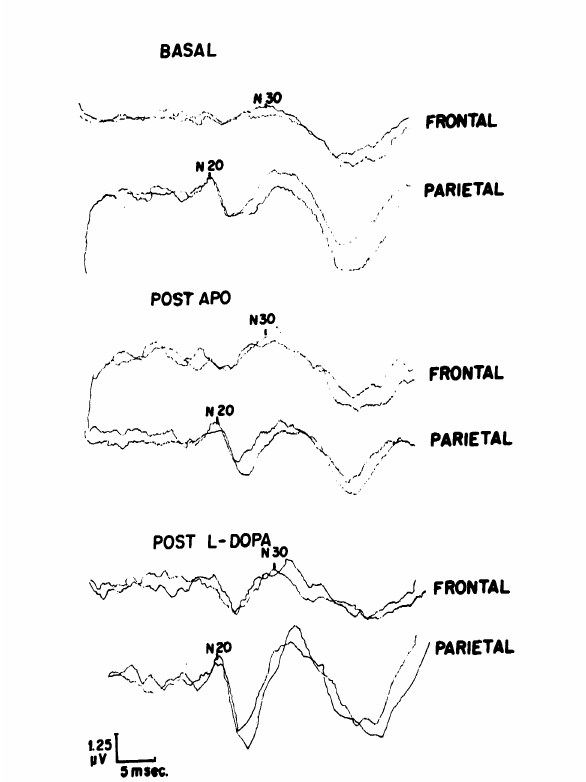
FIG. 2. Patient 3, a 67-year-old man. In the basal condition a very low amplitude frontal potential is evoked. Twenty min following subcutaneous apomorphine, a clear-cut frontal N30 was recorded. After using levodopa for a month, the N30 potential obstained was very